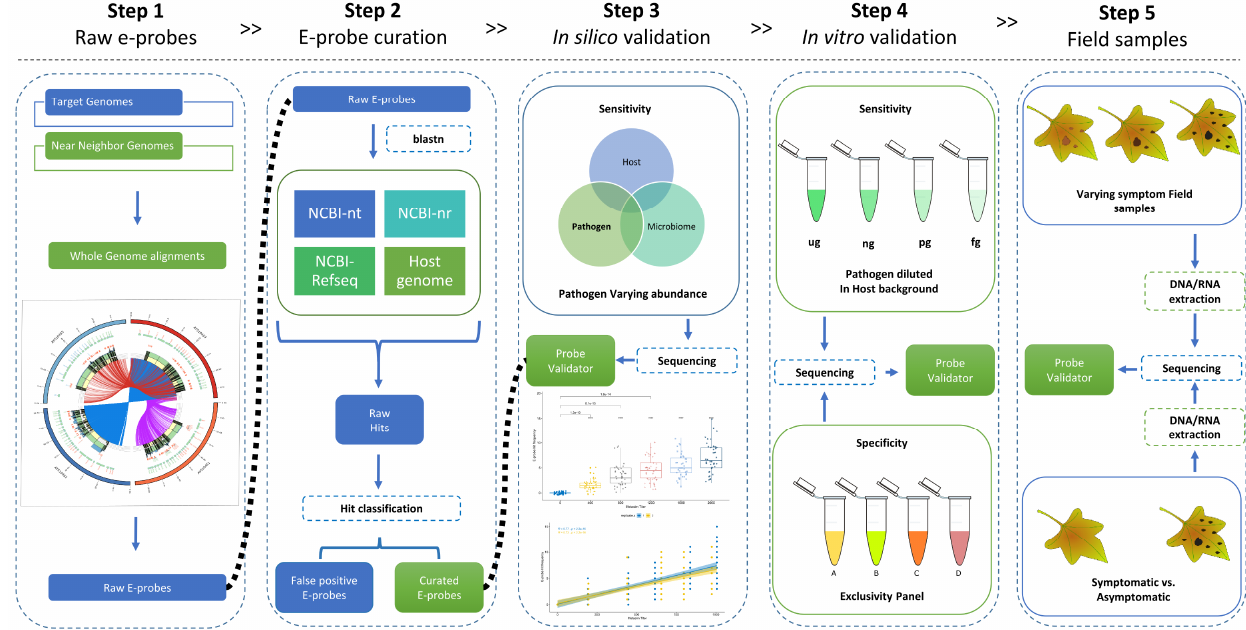
Figure 1. Full MiFi ® pipeline for the development, curation and validation of e-probes. Complete or partially assembled genomes are used in whole genome alignments of a target pathogen and near neighbor candidates. E-probes are curated in step two, using the National Center for Biotechnology Information (NCBI) reference databases. Subsequent steps (3–4) allow the user to do both in-silico and in-vitro validations to assess sensitivity and specificity. Finally, in step five, the e-probes are assessed using field samples with and without symptoms, and/or known positive/negative.